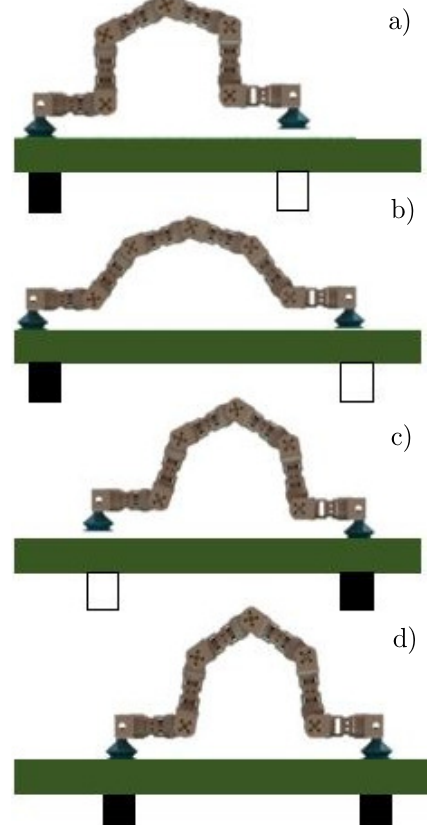
Figure 4. Alternative representation of a gait cycle for the WBRD; ( a ) The rear pump is on and a first robot manipulator structure is adopted; ( b ) The reference trajectories force the robot to expand almost to reach a 0 degrees configuration; ( c ) The pumps switch and the second robot manipulator configuration is adopted, the reference trajectories for the movement of the robot until a desired position; ( d ) A second switching in the gait cycle is performed to complete the walking path emulating the real